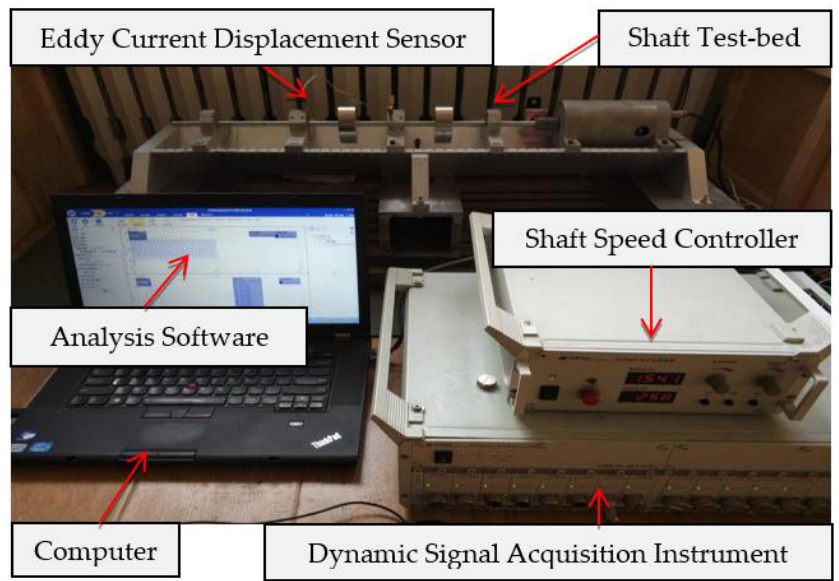
Figure 17. The test rig and signal acquisition system of a faulty shaft.